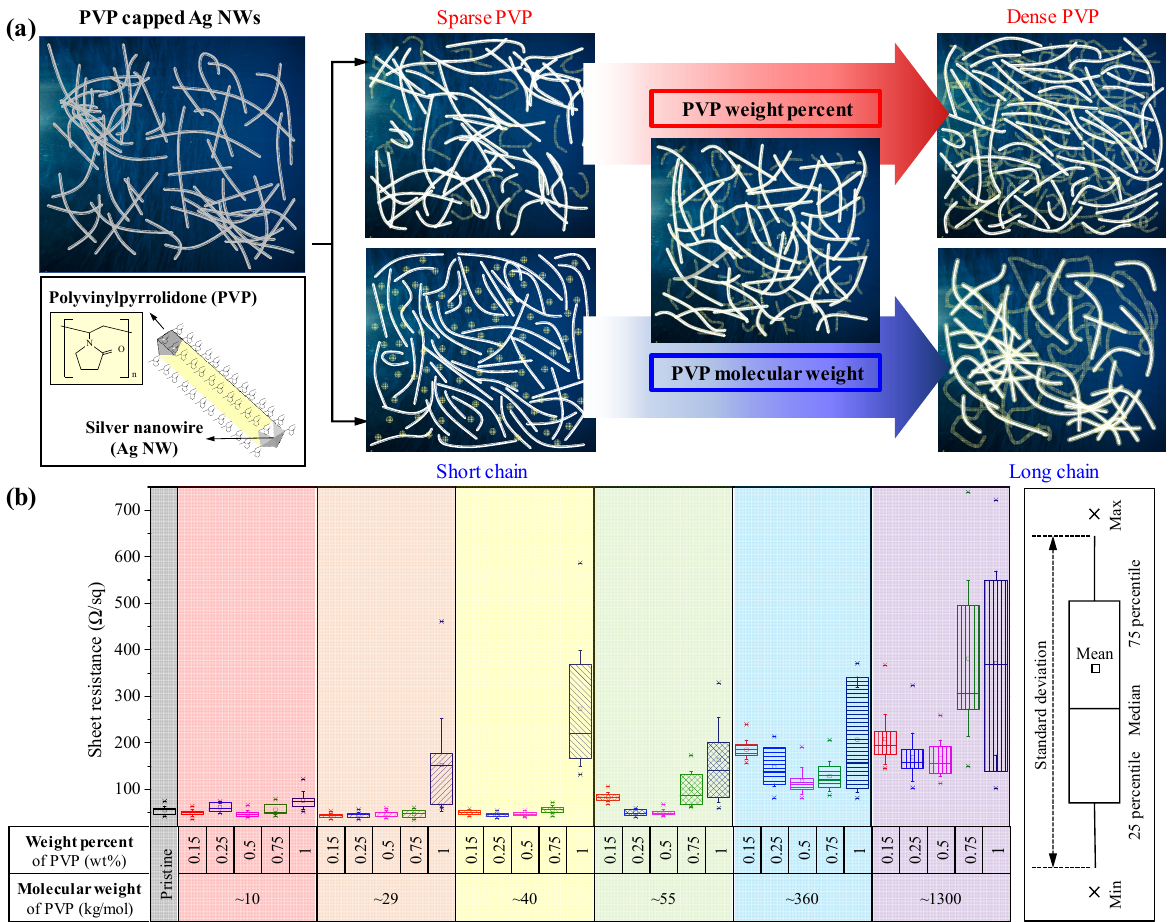
Figure 3. Dispersion of Ag NW-PVP composite solution with regard to PVP molecular weight and weight percent: ( a ) Schematic of Ag NW dispersion mechanism by adding PVP and comparison of ( b ) sheet resistance with box plot.